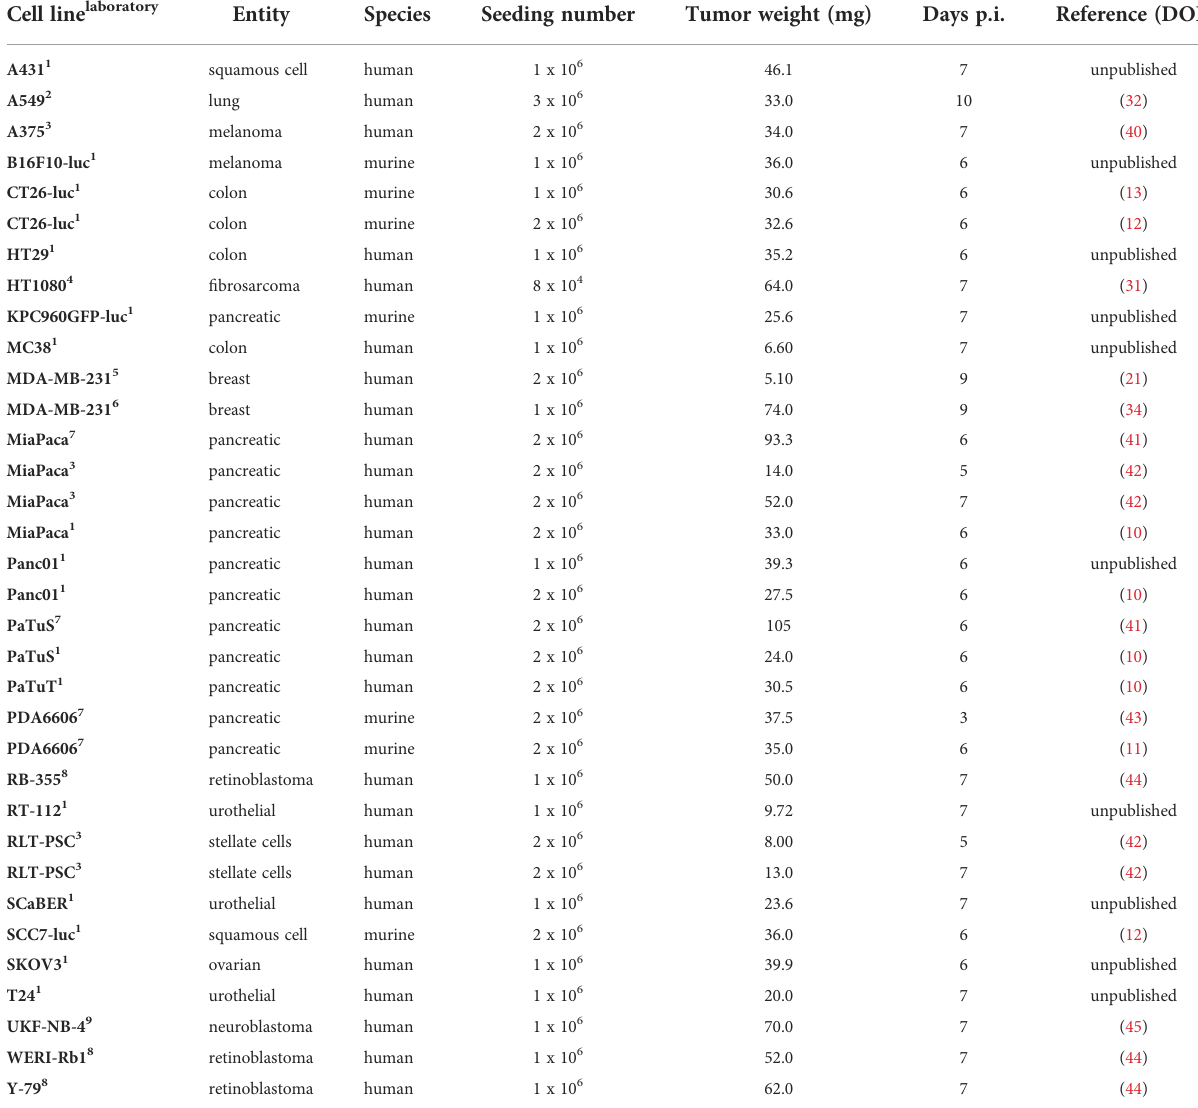
TABLE 2 List of cell lines that have been engrafted in ovo